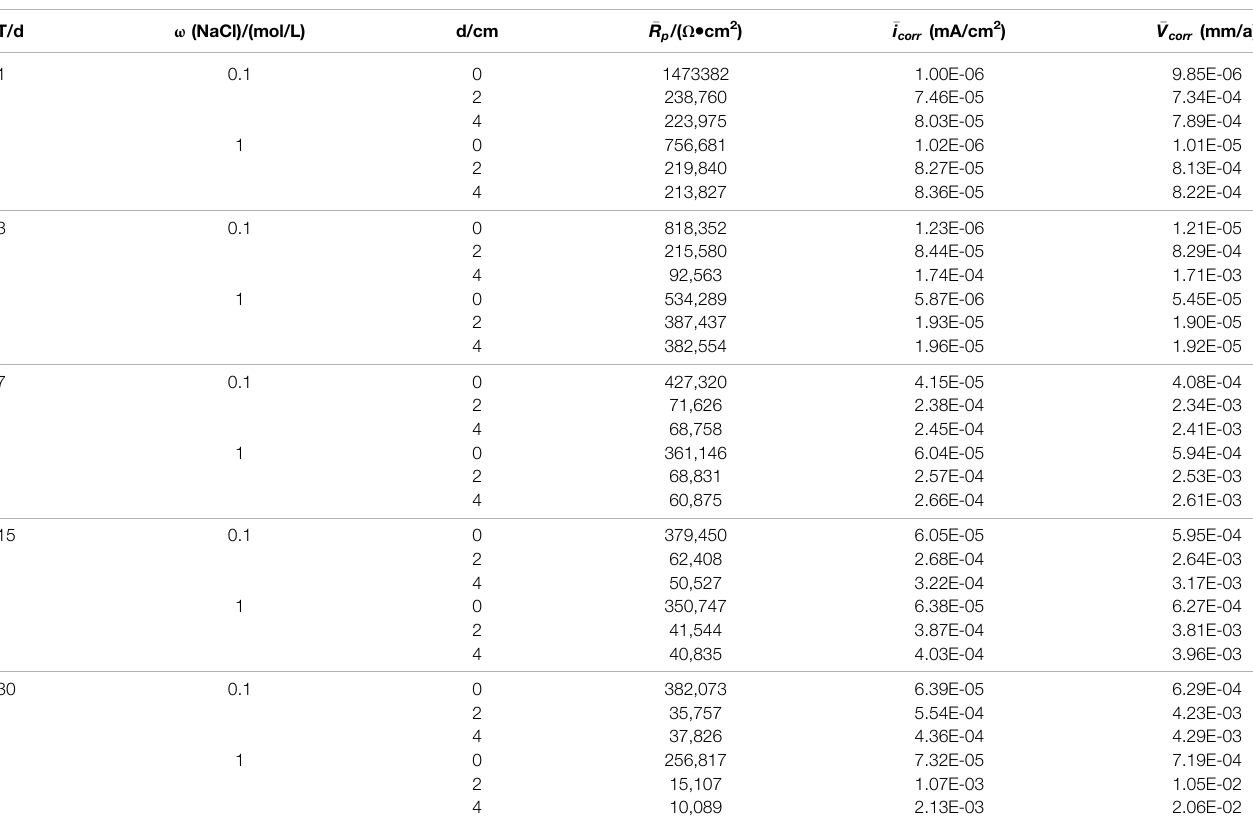
TABLE 3 | Analysis of the anode polarization